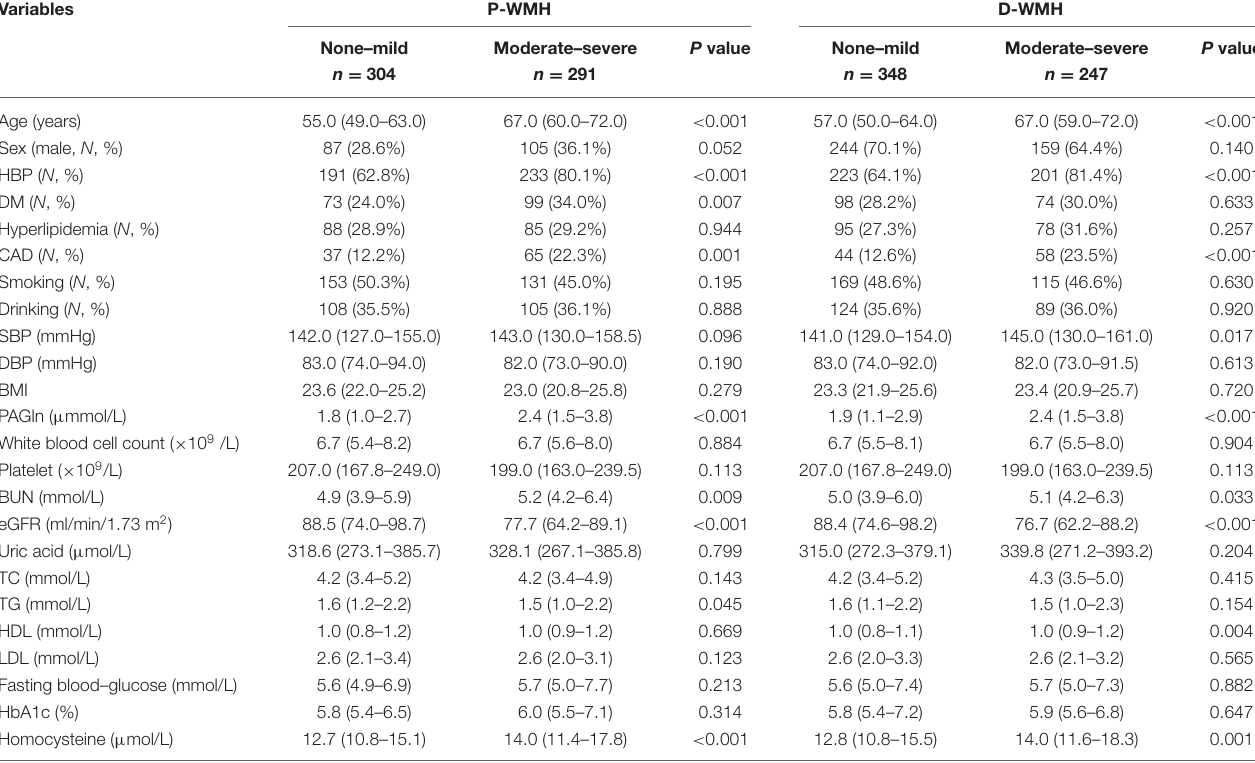
TABLE 4 | Characteristics of patients according to the scales of P-WMH and D-WMH.